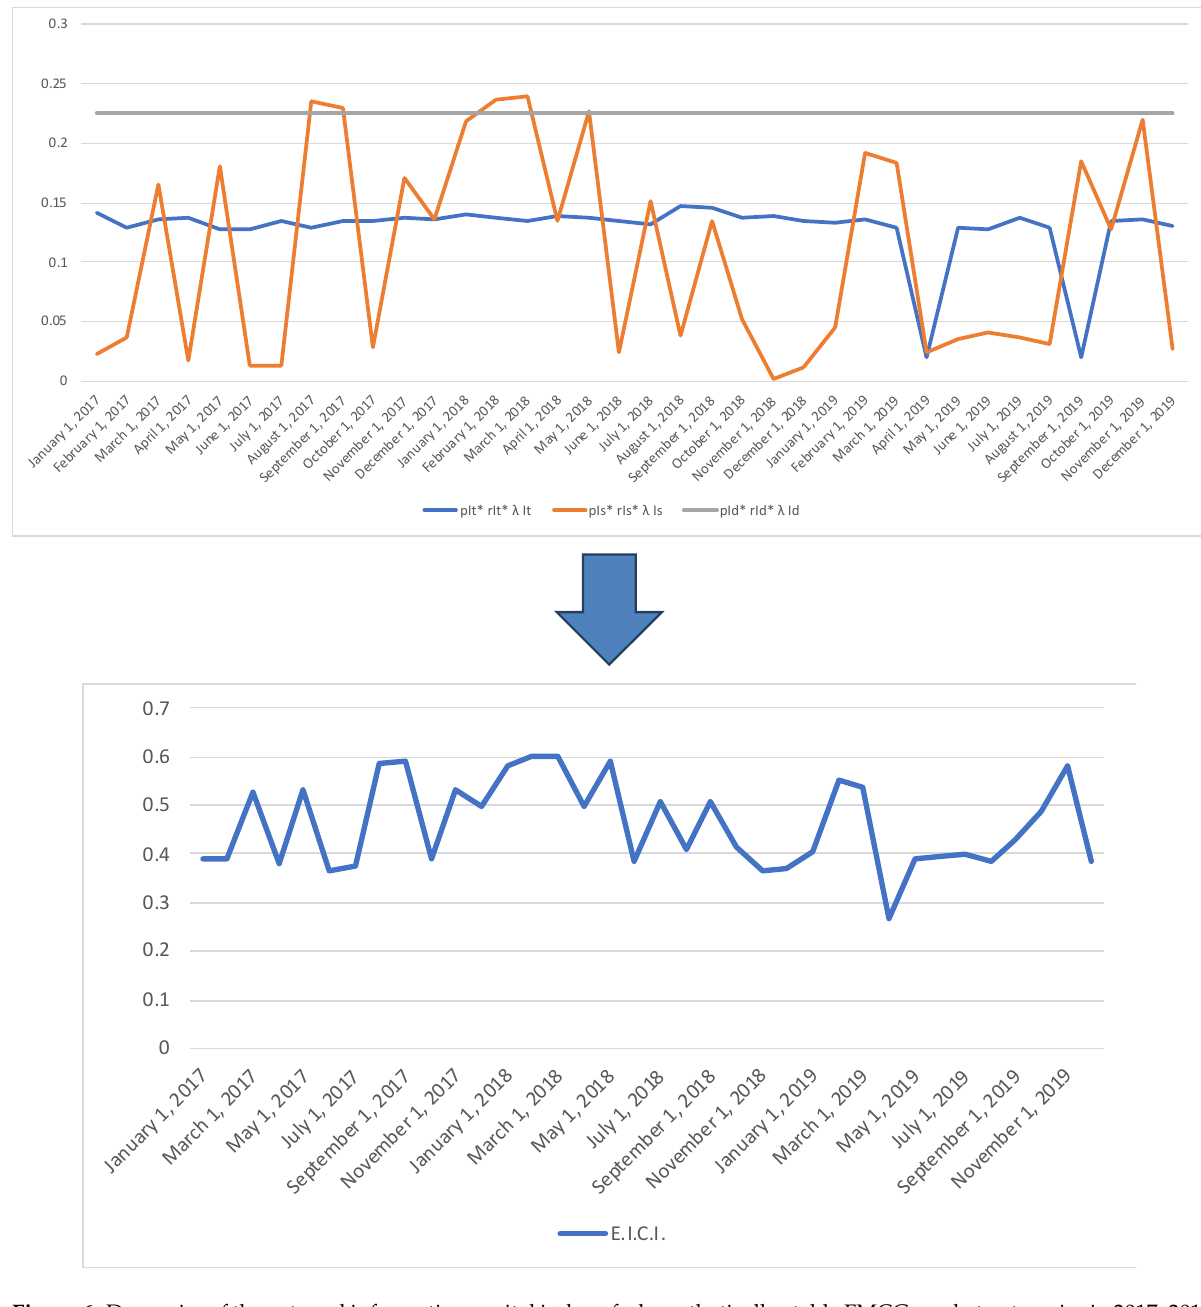
Figure 6. Dynamics of the external information capital index of a hypothetically stable FMCG market enterprise in 2017–2019. Source: developed by the authors.